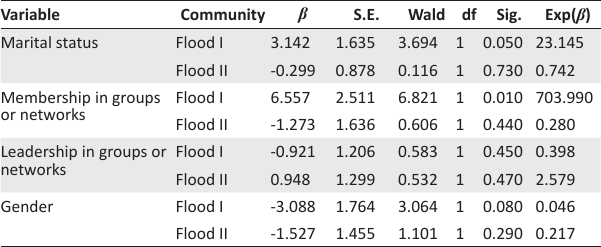
TABLE 5: The level to which social capital variables influence coping strategies by floods.